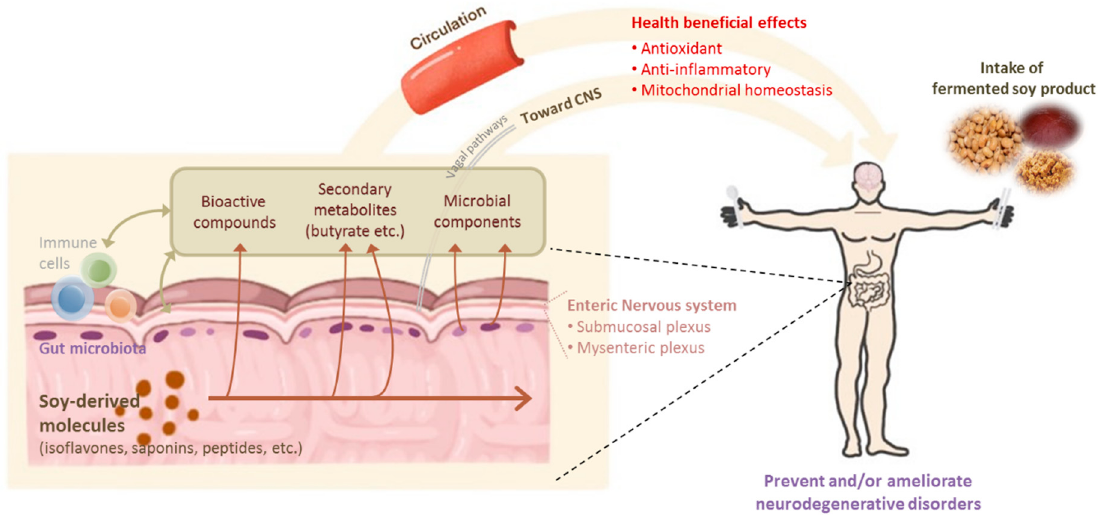
Figure 4. Health-beneficial effects of fermented soy products on neurodegenerative